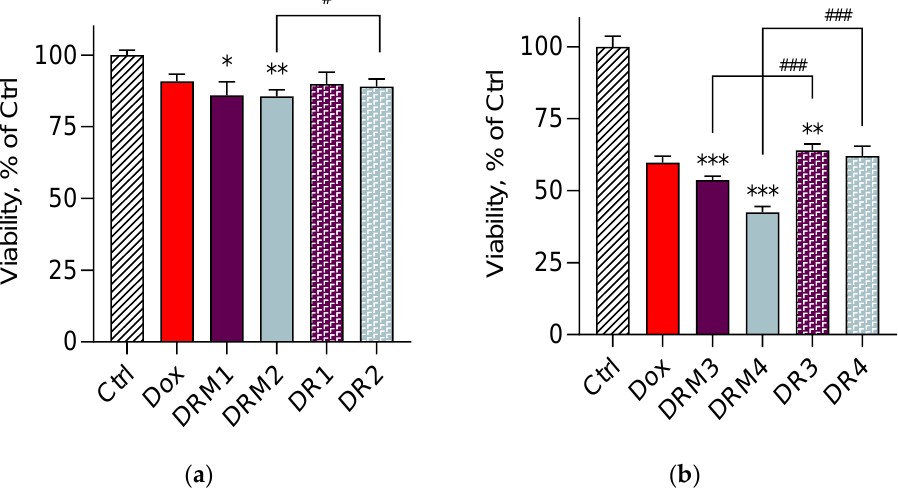
Figure 10. In vitro cytotoxic effect in lymphoma L5178 cells treated with the double-loaded doxorubicin/resveratrol micelles (DRM) and corresponding hydroalcoholic solutions of doxorubicin/resveratrol (DR). Ctrl—non-treated cells; DRM1 (double-loaded micelles) and DR1 (standard solution) containing 0.25 µM Dox and 1.3 µM Res ( a ); DRM2 (double-loaded micelles) and DR2